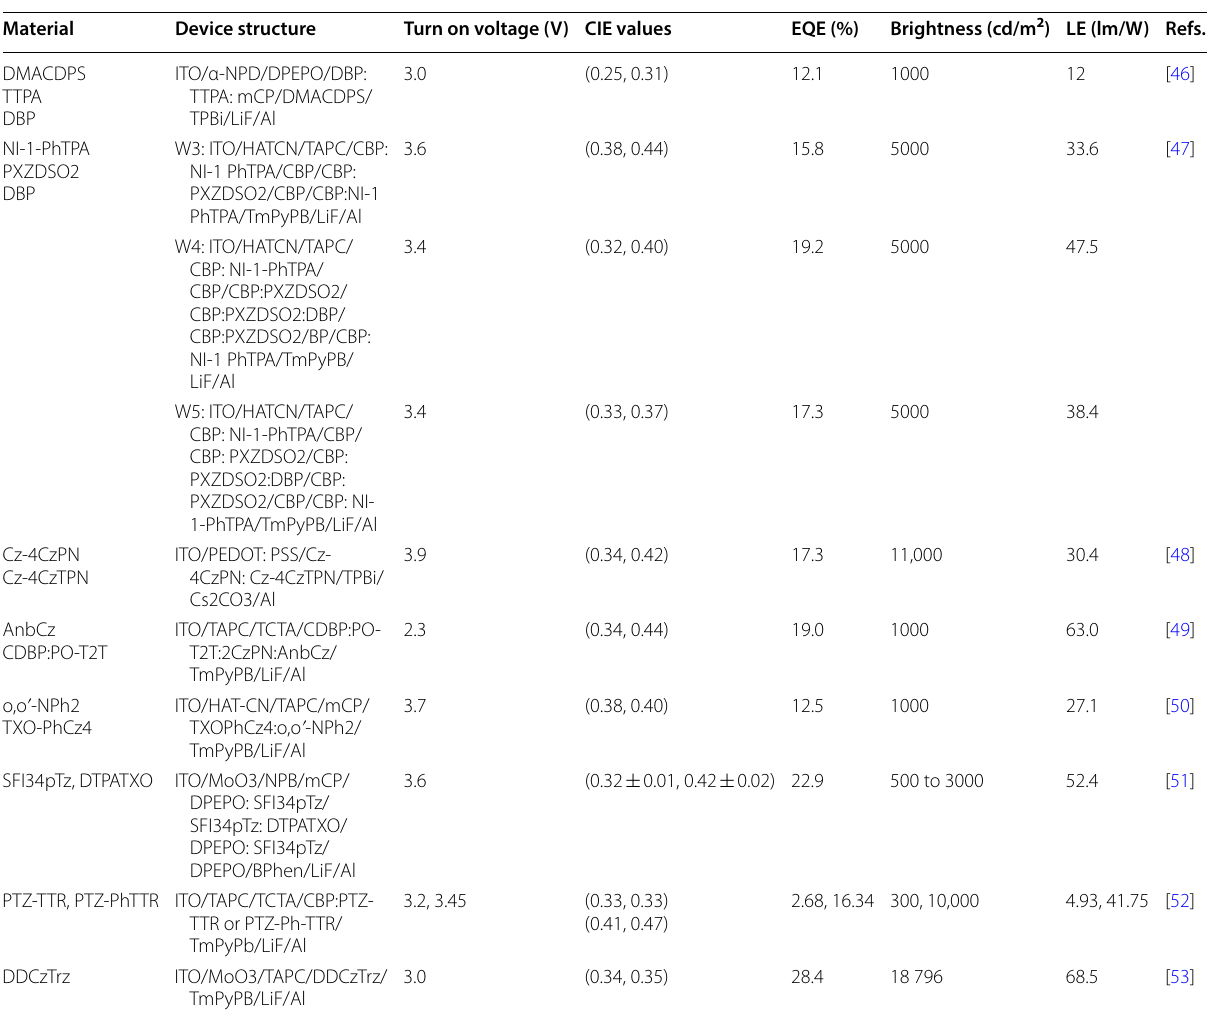
Table 2 EL performances of different TADF materials Material Device structure Turn on voltage (V) CIE values Brightness (cd/m 2 ) LE (lm/W)